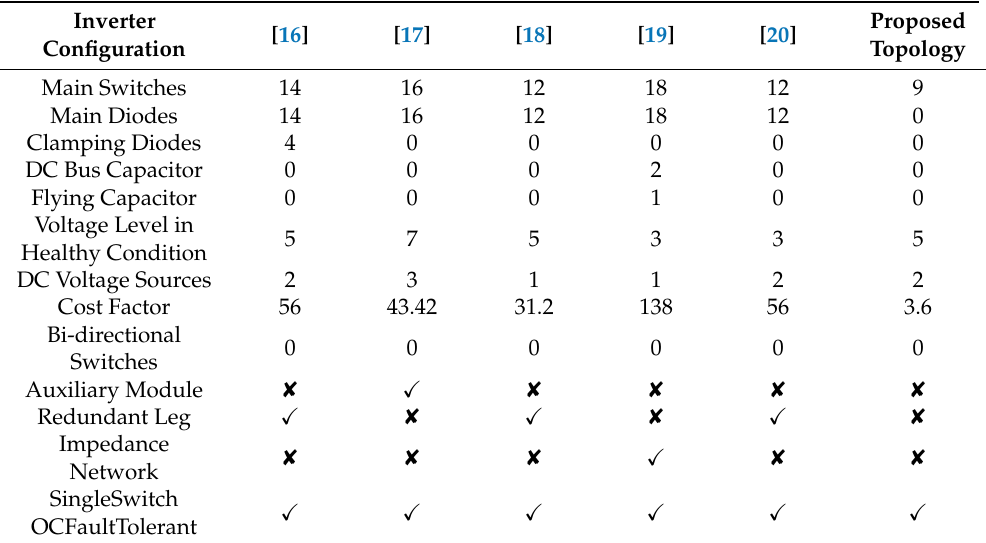
Table 7. Comparison of the total parts count for the proposed fault-tolerant topology with the existing